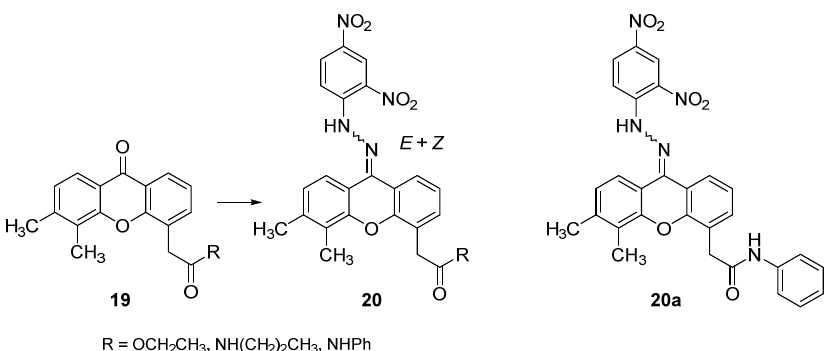
Figure 15. DMXAA hydrazone derivatives.